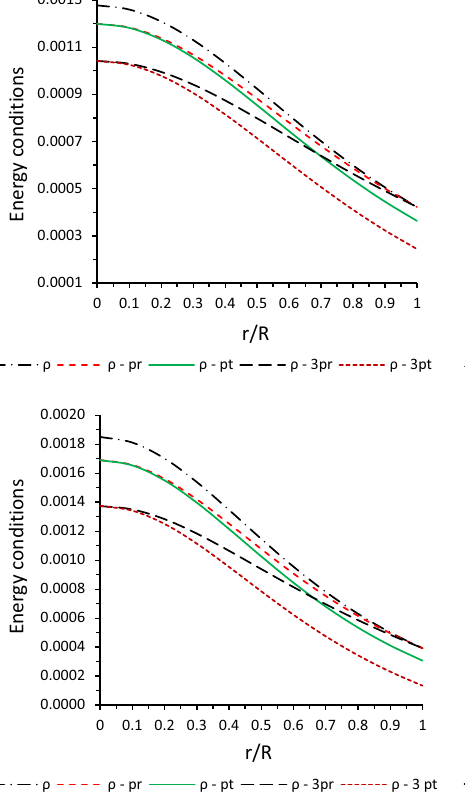
a = 0 . 00393, b = 0 . 0025, c = 0 . 01074, A = 0 . 4905, B = 1 . 2293, M = 1 . 3 M (cid:7) and R = 8 . 849 km for EXO 1785-248, (iii) a = 0 . 005, b = 0 . 0004, c = 0 . 01481, A = 0 . 4654, B = 1 . 0551, M = 1 . 667 M (cid:7) and R = 9 . 438 km for PSR J1903+327, (iv) a = 0 . 0055, b = 0 . 0002, c = 0 . 0155, A = 0 . 44506, B = 1 . 1286, M = 1 . 58 M (cid:7) and R = 9 . 1 km for 4U 1820-30